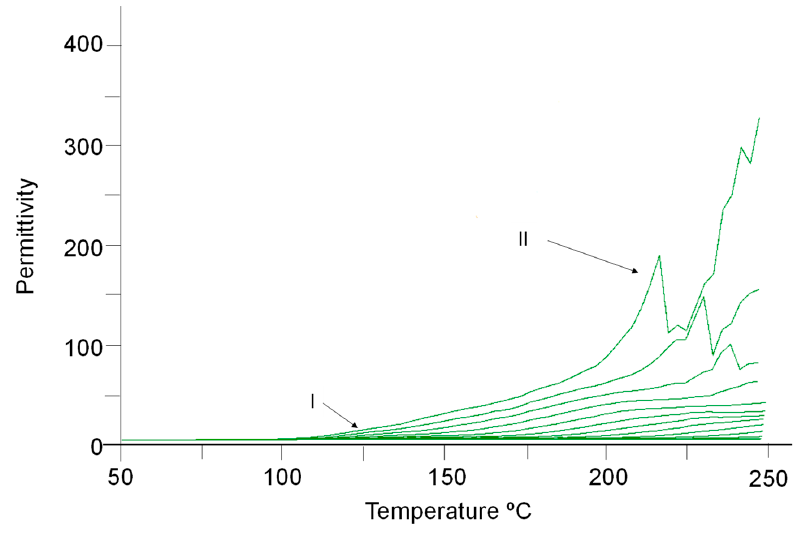
Figure 11. Permittivity ε ′ vs. temperature at various applied frequencies for the system DGEBA/mXDA/AuNP (8.5%). Arrows indicate the existence of two transitions: I (see Figure 9) and II, Tsagaropoulos and Eisenberg transition.